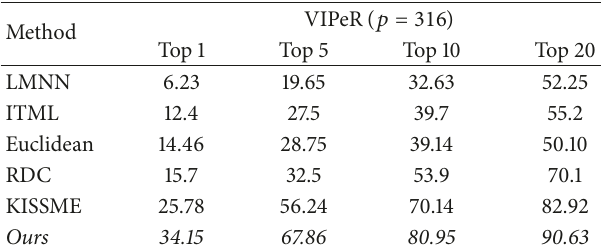
Table 4: Comparison of state-of-the-art results of metric learning reported with VIPeR database. The cumulative matching scores (%) at ranks 1, 5, 10, and 20 are